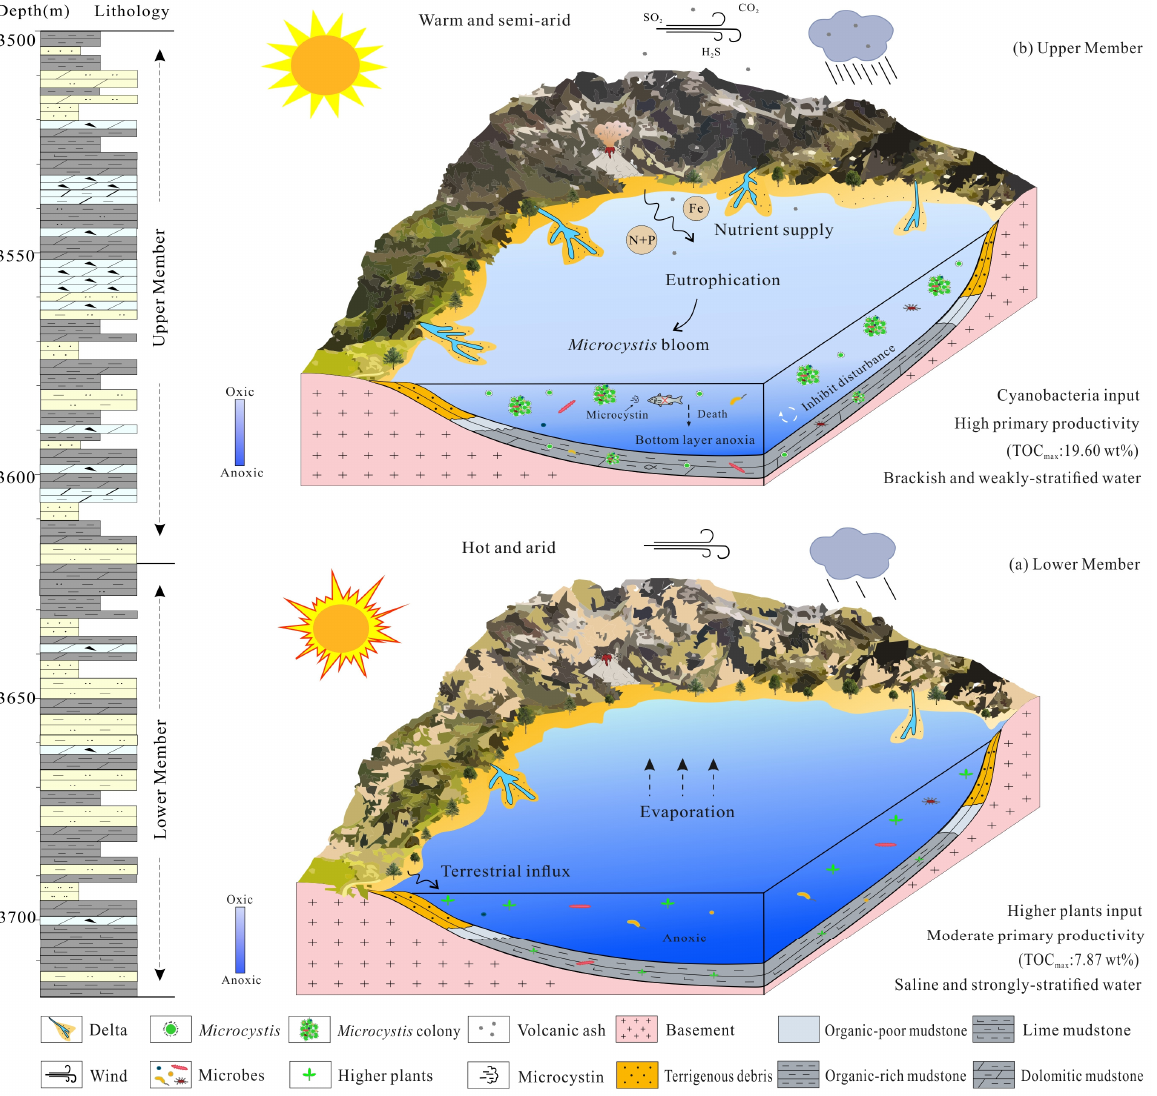
Figure 11. Schematic diagram of a Permian Microcystis bloom and its hydrocarbon effect. ( a ) Paleoenvironment of the lower member. ( b ) Paleoenvironment of the upper member.